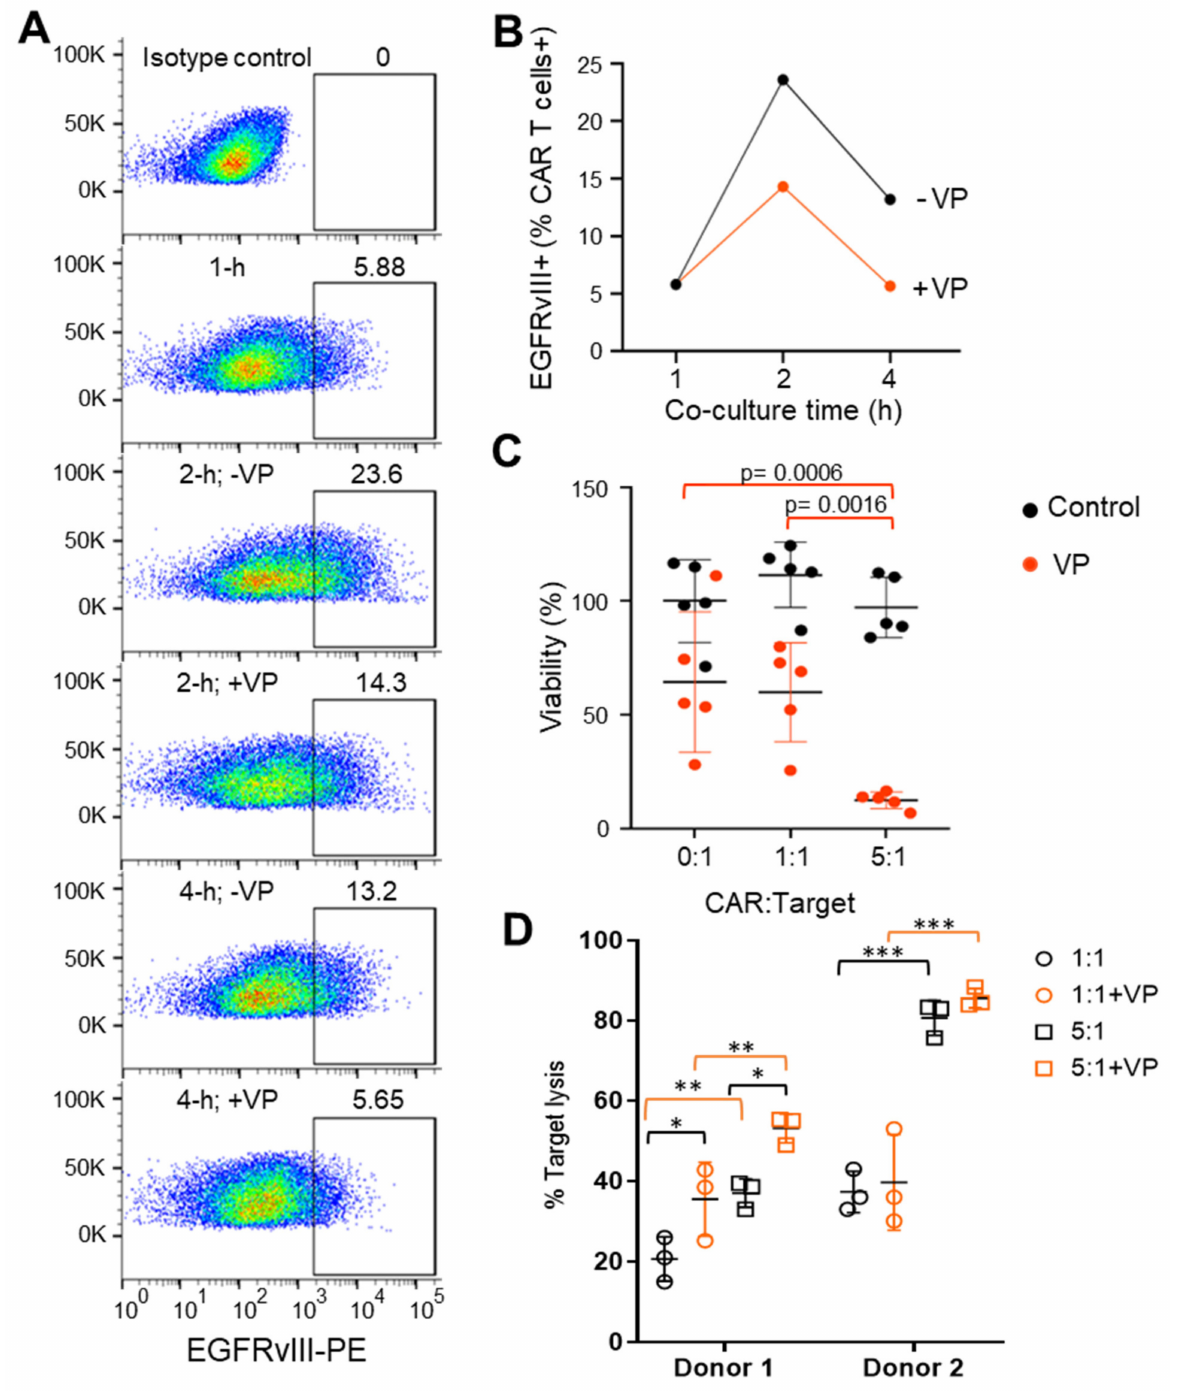
Figure 5. Verteporfin inhibits CAR-induced trogocytosis and increases CAR activity. ( A ) Representa- tive flow cytometry example of EGFRvIII expression on Donor 1 CAR prior to or following co-culture with targets (U87-EGFRvIII) in the absence (-) or presence (+) of verteporfin (VP). The gate is set against the isotype control and was conducted in triplicate. ( B ) Summarized kinetic data from A of CAR T cell EGFRvIII expression in the absence and presence of VP. ( C ) Target (U87-EGFRvIII) cell via- bility treated with Donor 1 CARs in the absence (control; black circles) or presence of verteporfin (VP; red circles) for 24 h. A Two-way ANOVA test and Turkey’s multiple comparisons were conducted with no statistical significance between the control groups (black circles). Statistical